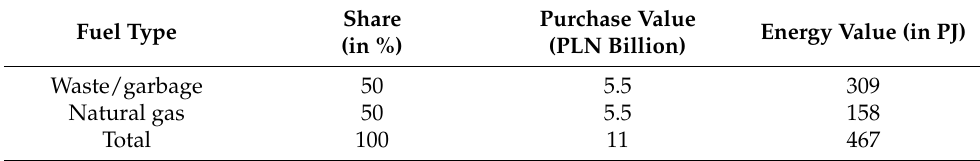
Table 5. Estimation of the energy value for scenario 8.